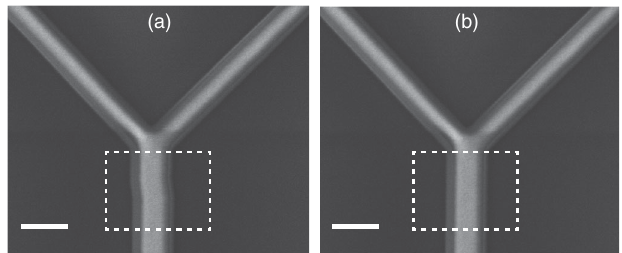
FIG. 9. Dependence of Q and S th on the corrugation width. FIG. 11. ebeam lithography stitching errors. An example of a F Square-shaped polygon resonators with corrugated widths are device with (a) and without (b) stitching errors after the ebeam simulated. Q and S th are shown in (a) and (b) for w 0 ¼ 0 . 2 μ m lithography process. The area of stitching is marked with the F white dashed square for comparison. Scale bars correspond to (blue) and w 0 ¼ 0 . 7 μ m (orange). The diamond marker corre- 500 sponds to the device used in the force sensitivity experiment.